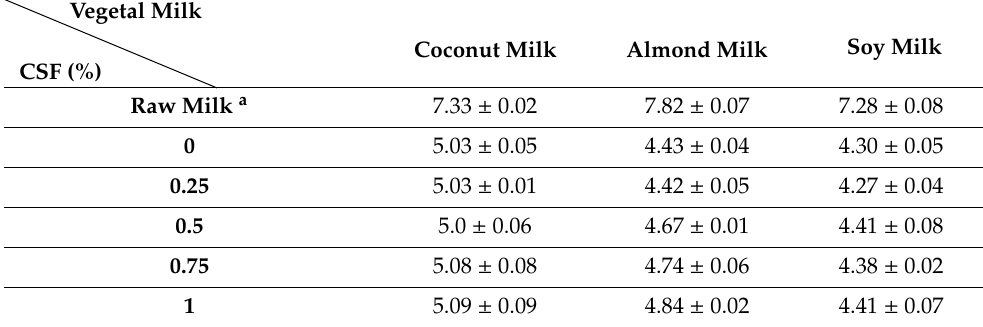
Table 5. pH measurements results. The values are the mean of three experiments ± standard deviation.